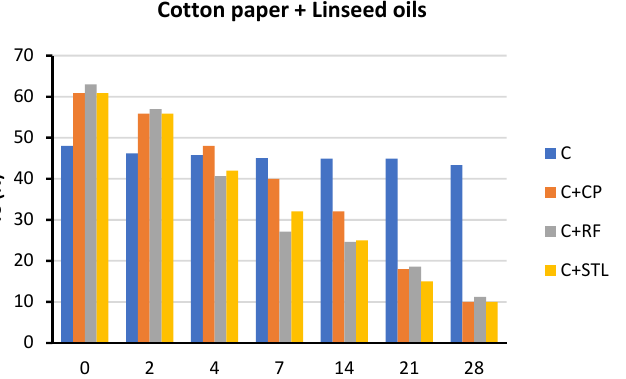
days of ageing; ( d ) 21 days of ageing. of ageing; ( d ) 21 days of ageing.